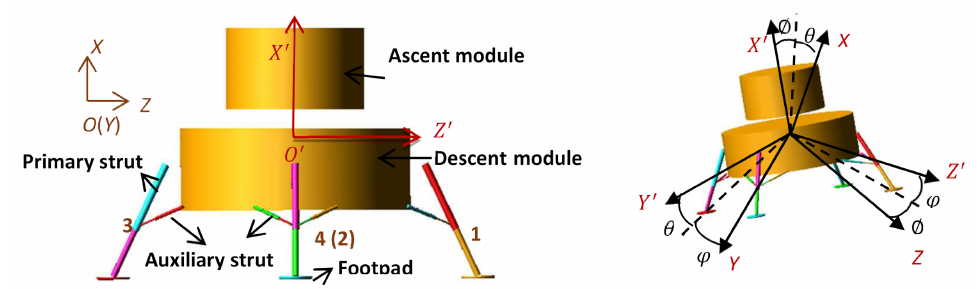
Figure 4. Overall Scheme of a manned lunar